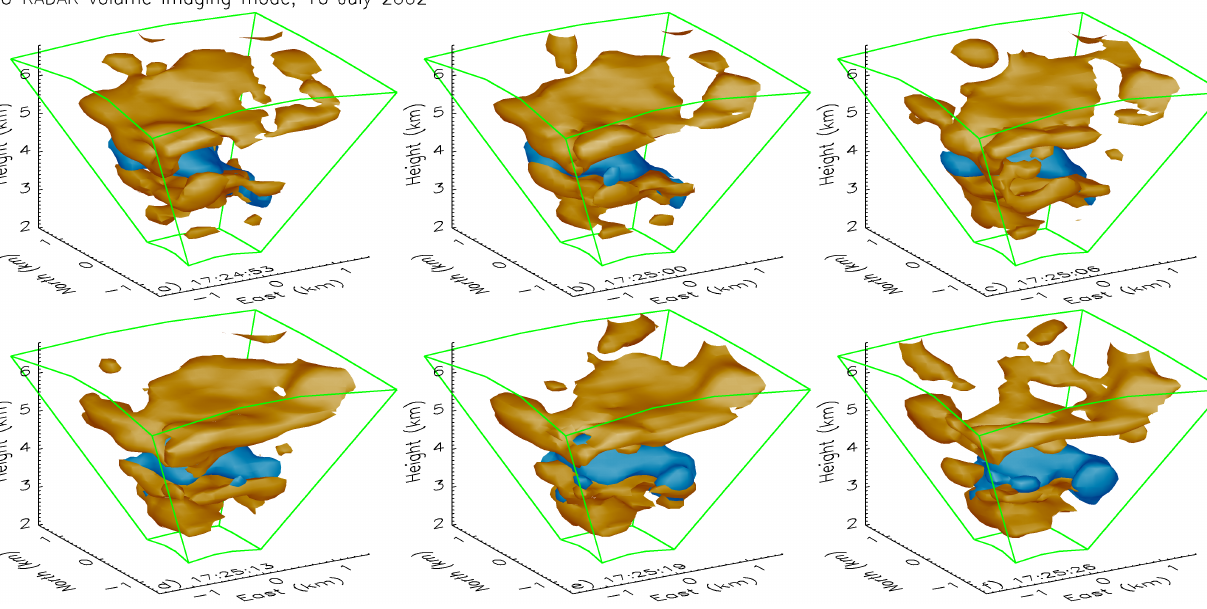
Fig. 13. ( a )–( f ) Three-dimensional views of deep convection for plots 85–90 of Figs. 11b, c. Red shading is clear-air echo, 35dB isosurface; blue shading is precipitation echo, 40dB isosurface; green lines are edges of volume imaged in Fig.